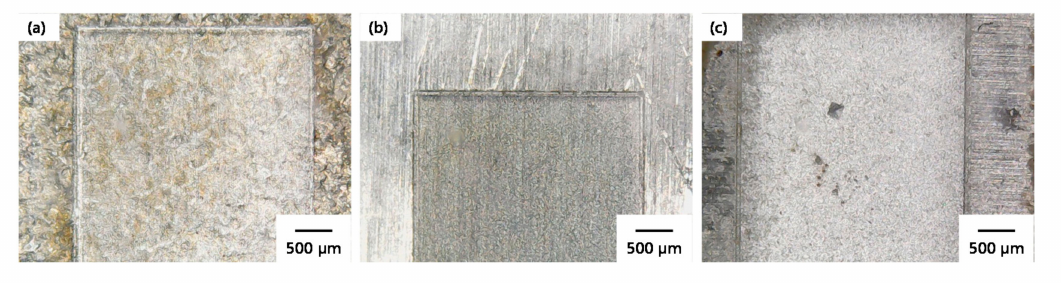
Figure 11. Micro-impressions produced under the optimized laser parameters on; ( a ) TiA, ( b ) NiA, ( c )